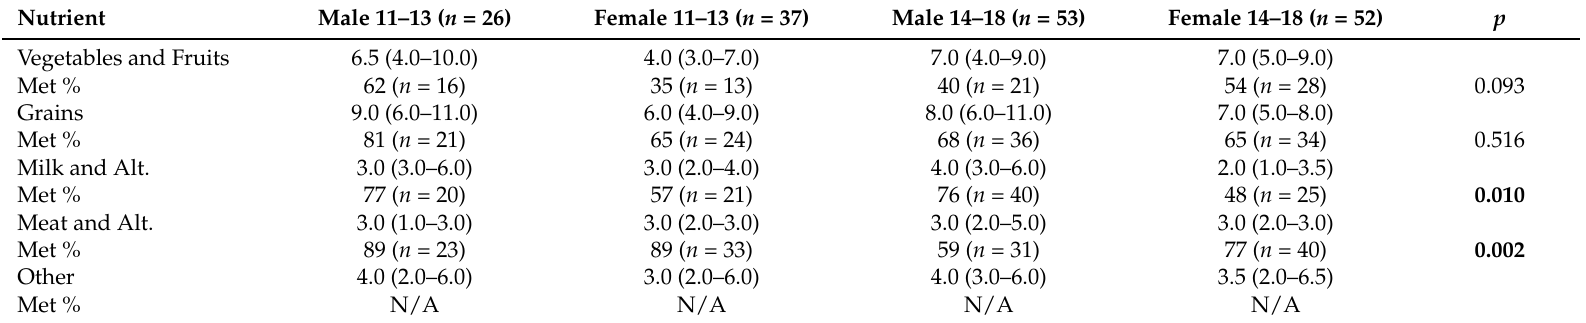
Table 4. Canada’s Food Guide